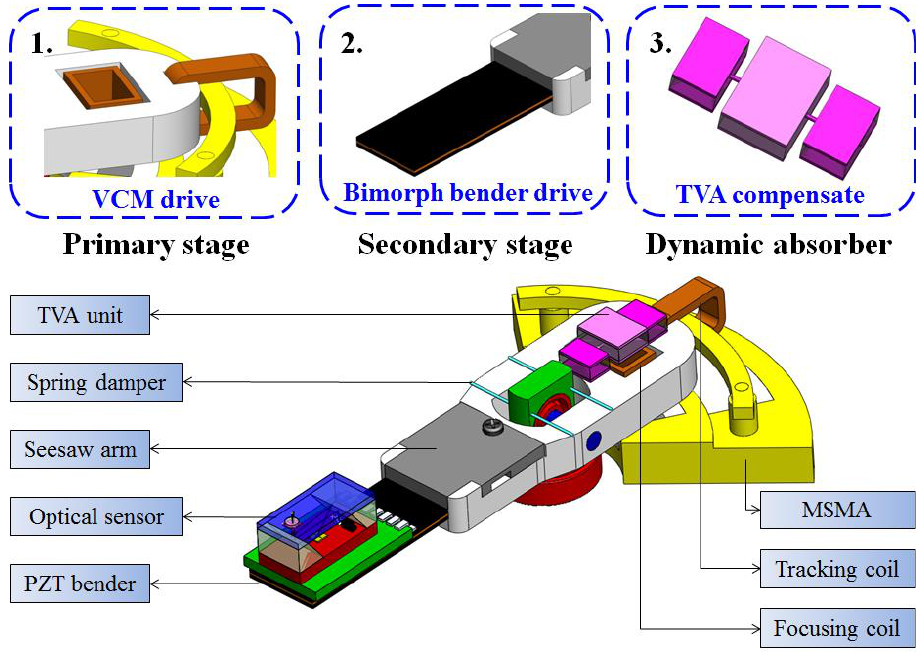
Figure 1. Schematic illustration of the bimorph dual-stage actuator with the TVA unit